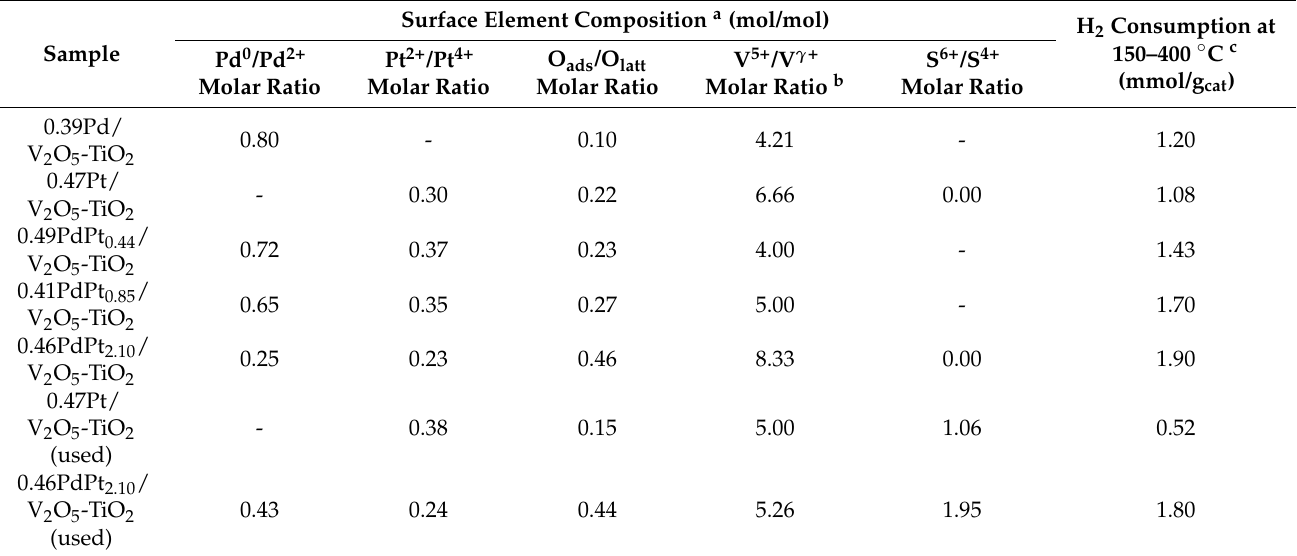
Table 3. Surface element compositions and H 2 consumption of the fresh and SO 2 -treated